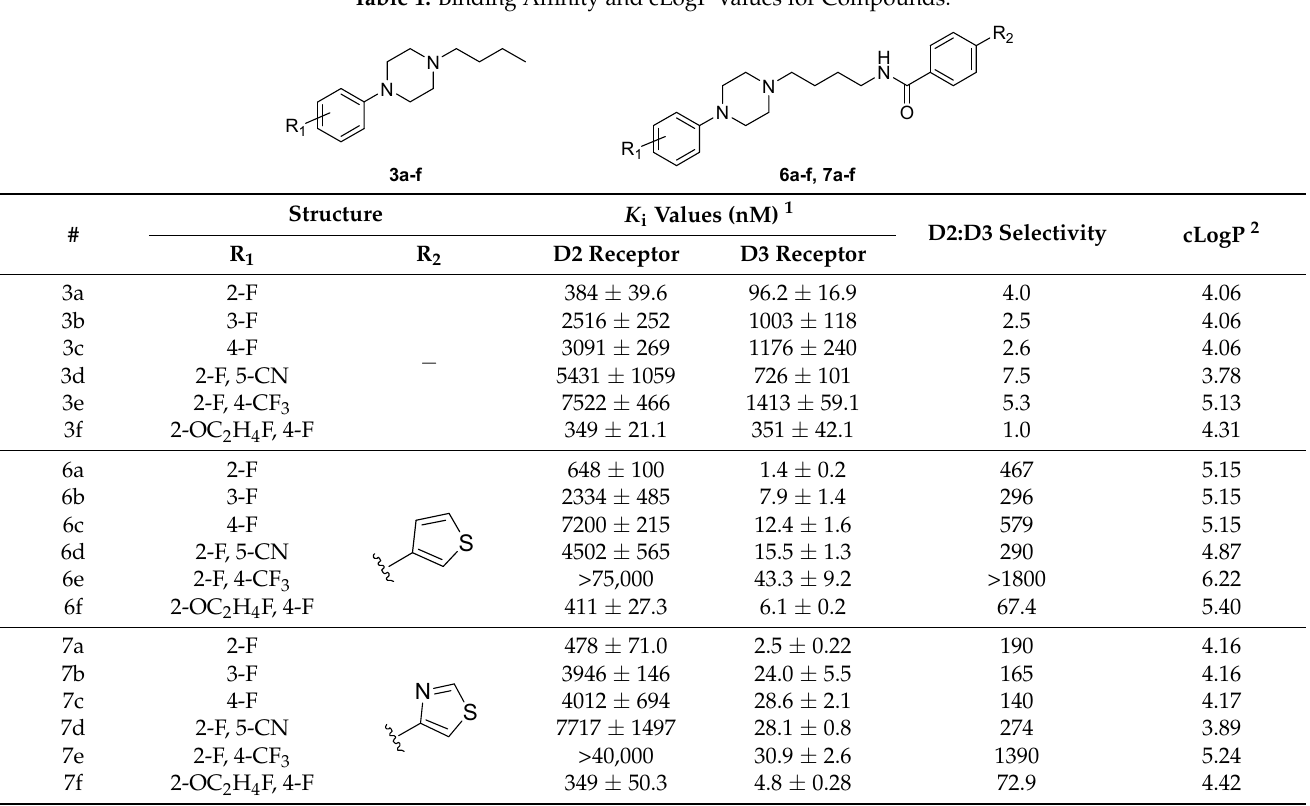
Table 1. Binding Affinity and cLogP Values for Compounds.